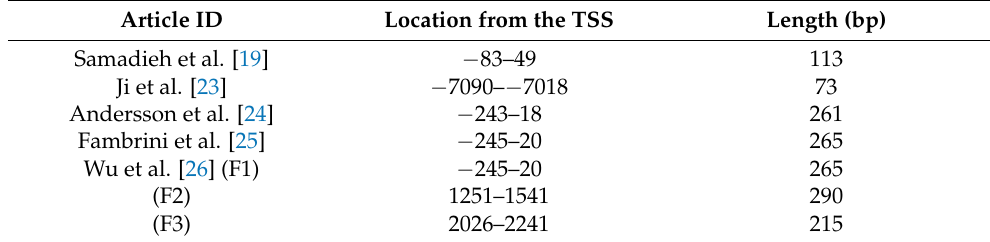
Figure 2. The position of the DNA methylation in HOXA10 analyzed by the included studies [23–26]. Table 3. The DNA methylation locations from the transcription start site analyzed by the included